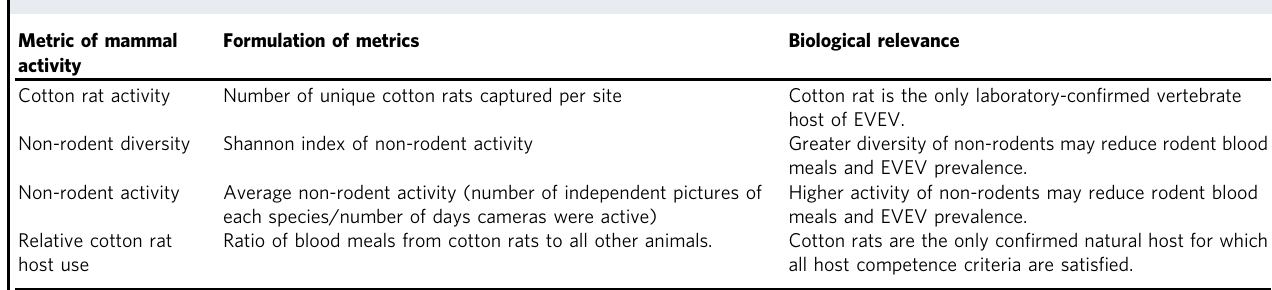
Table 3 Metrics of mammal activity used in the